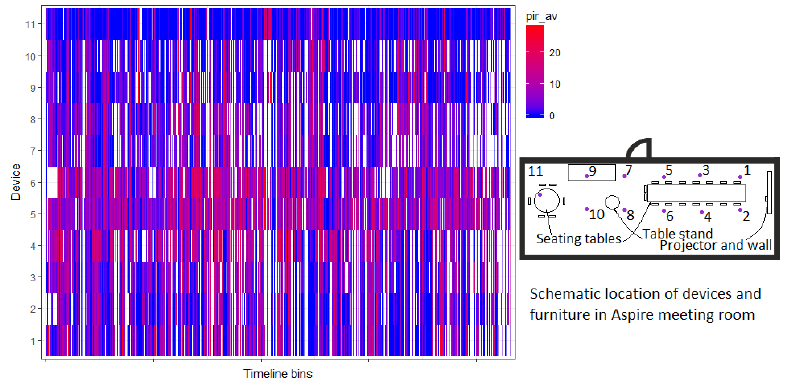
Figure 9. Average pir readings during meetings ordered over 15-minutes time bins.